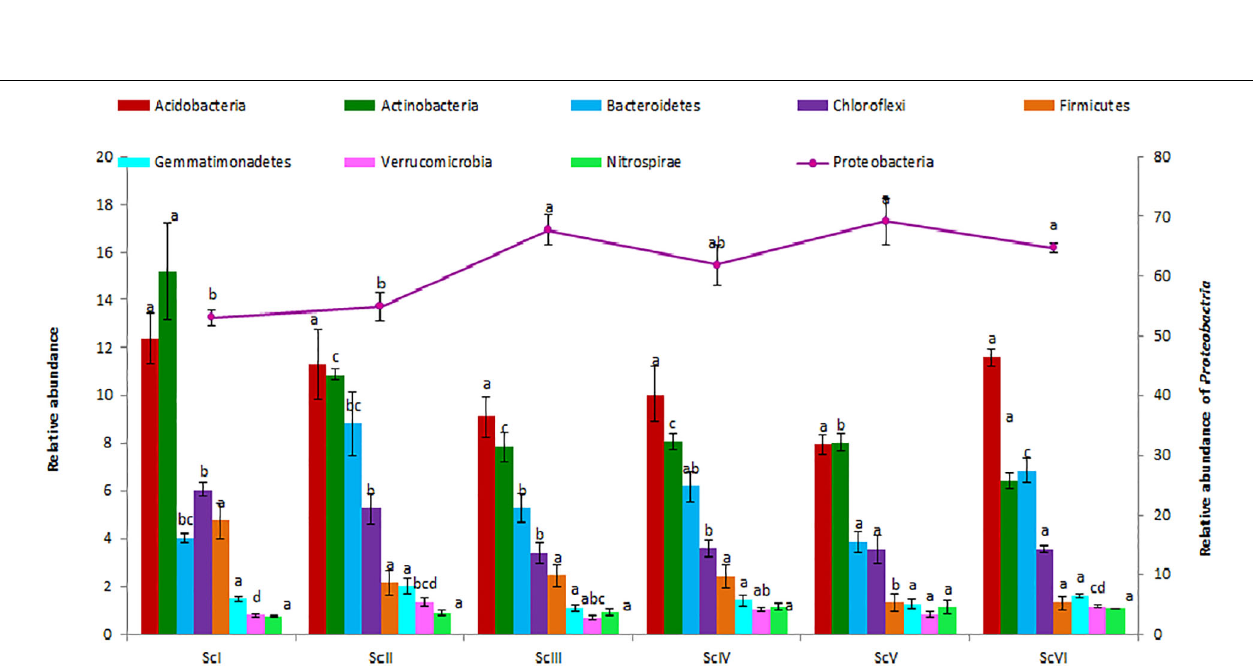
FIGURE 2 | Principal coordinate analysis (PCoA) of soil bacterial β -diversity based on weighted UniFrac.